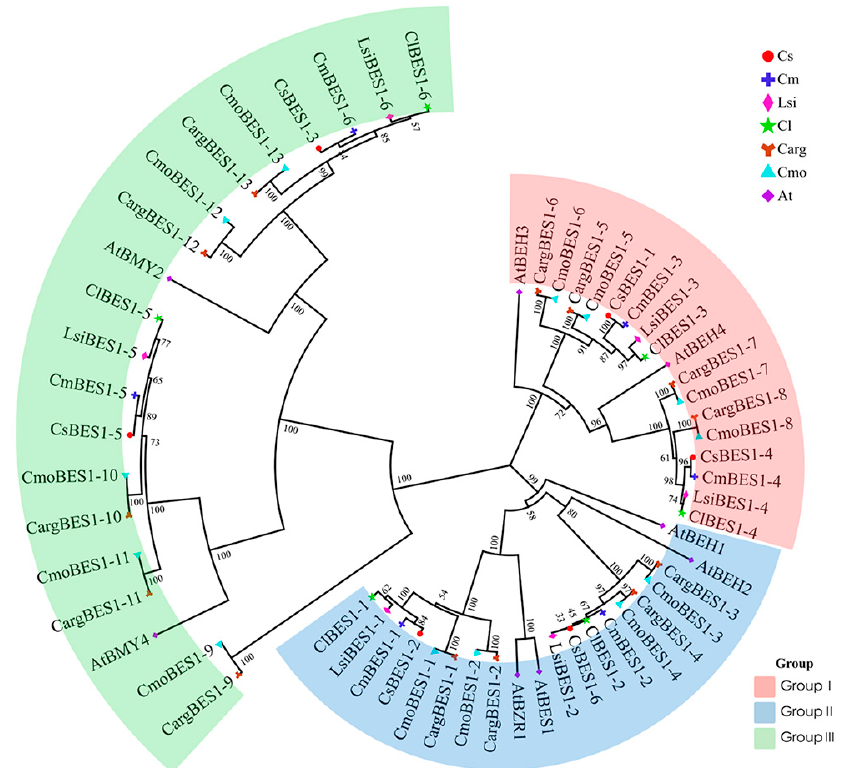
Figure 1. Phylogenetic relationships of BES1 proteins from cucumber (Cs), melon (Cm), bottle gourd (Lsi), watermelon (CI), silver-seed gourd (Carg), winter squash (Cmo), and Arabidopsis thaliana (At). All BES1 proteins in the seven species were clustered into three groups represented by pink, blue, and green for Groups I to III, respectively. The generated phylogenetic tree included 6 BES1 proteins from cucumber, 6 from melon, 6 from bottle gourd, 6 from watermelon, 13 from silver-seed gourd, 13 from winter squash, and 8 from Arabidopsis thaliana . Gene information can be found in Table S1. 2.3. BES1s Members in Cucurbitaceae Showed Variations in Chromosomal